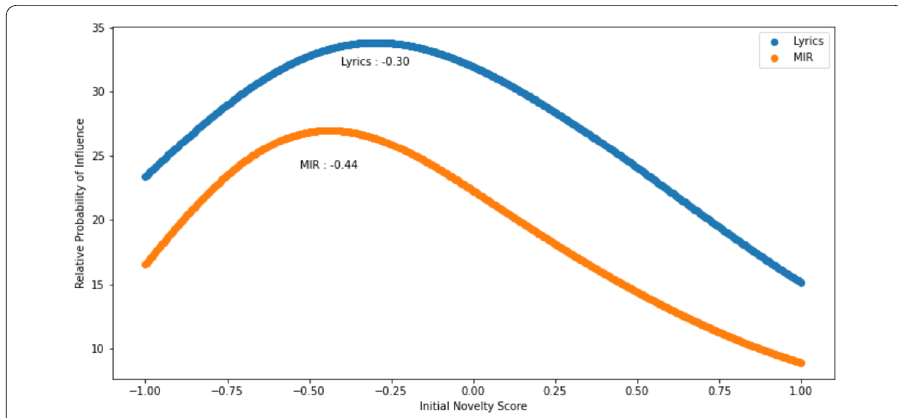
Figure 7 Relative probability of a song being in the bottom 10th percentile for relative novelty change based on initial novelty scores. We see that the probability decreases as either score moves away from the value that provides the optimal degree of differentiation within its modality. Since the relative probability values are a summation of probability estimates of a generated data set, they are dependent on the total number of data points generated for our sample, and should not be treated as an absolute probability value